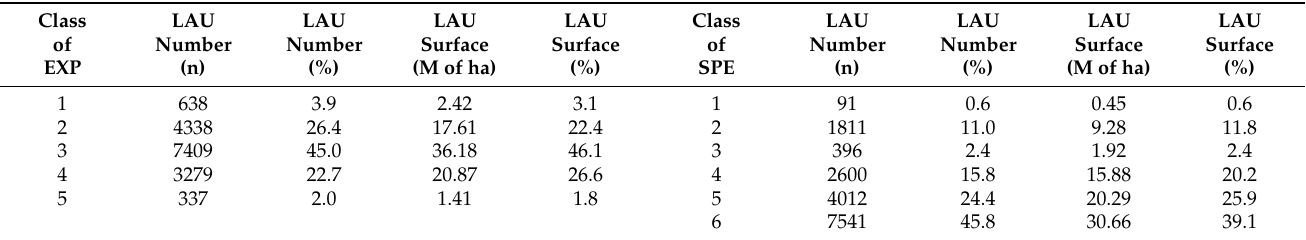
Table 7. Number and surface of LAUs falling in each class of the two indices (EXP and SPE) and relative percentage calculated on the total values for the second census date (C2). Class of